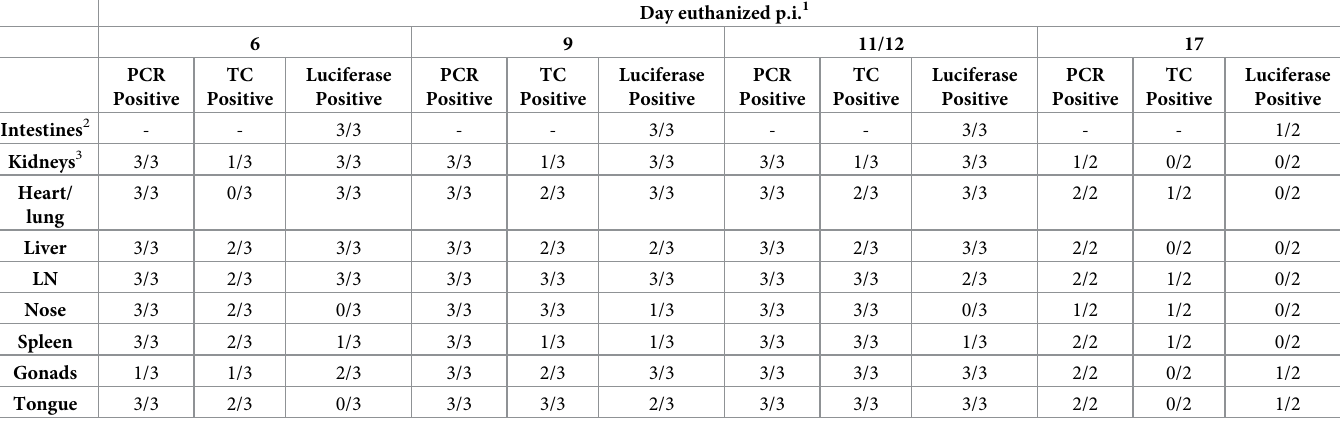
Table 2. Comparison of number of organs positive per time point for PCR, tissue culture and luminescence following challenge with